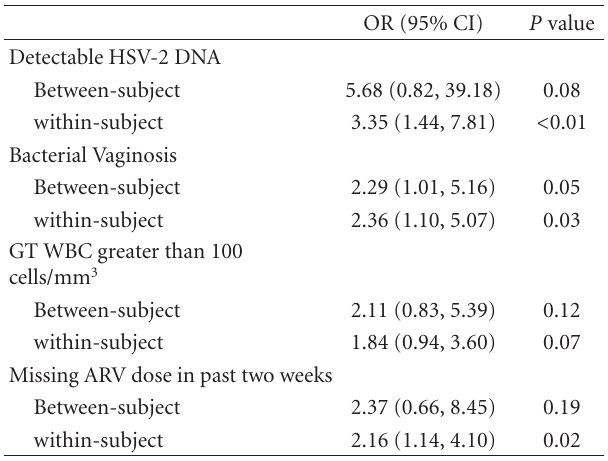
Table 4: Association between selected covariates and GT HIV-1 RNA